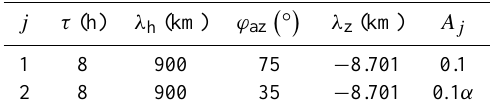
Table 1c. Same as Table 1b, but with identical vertical sense of